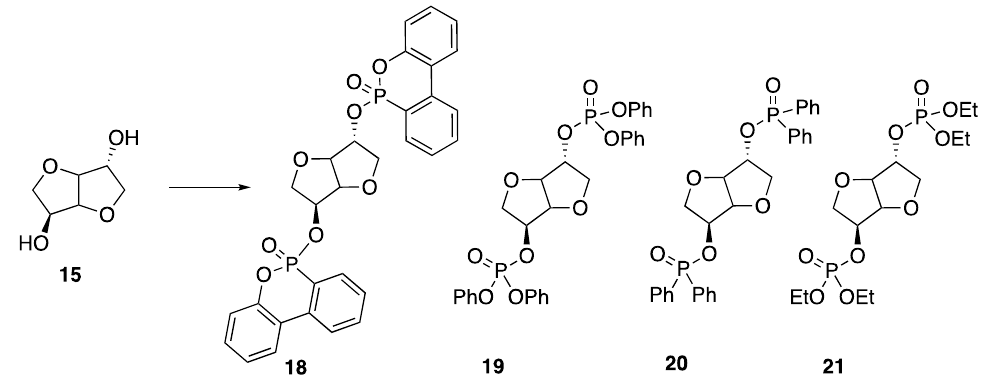
Figure 12. Isosorbide phosphate esters used as FR additives.